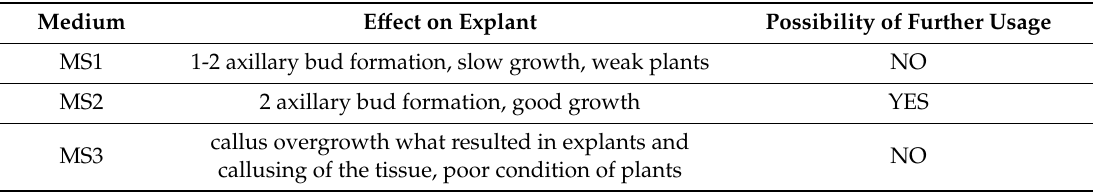
Table 3. E ff ects of di ff erent medium on P. tomentosa × P. fortunei regeneration.